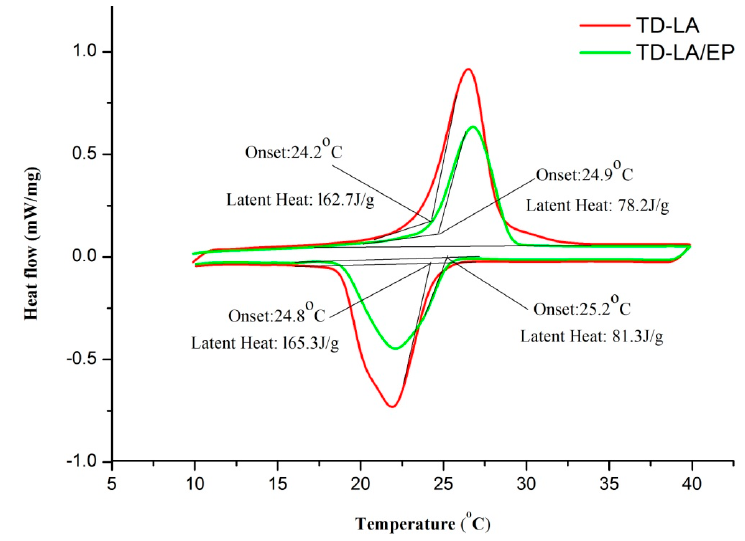
Figure 7. DSC curves of TD-LA and TD-LA/EP.